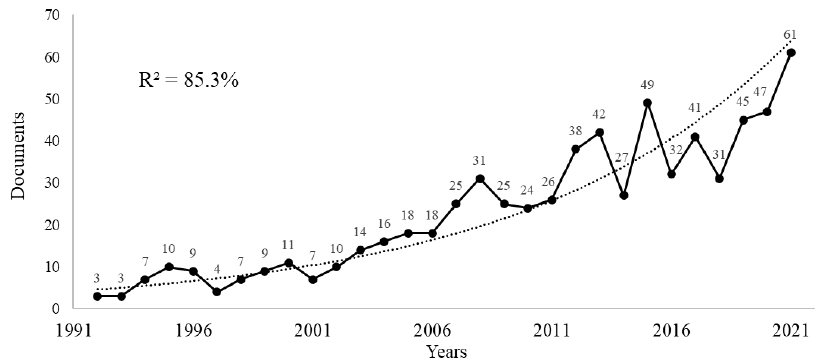
Figure 1. Annual publication trends graph.